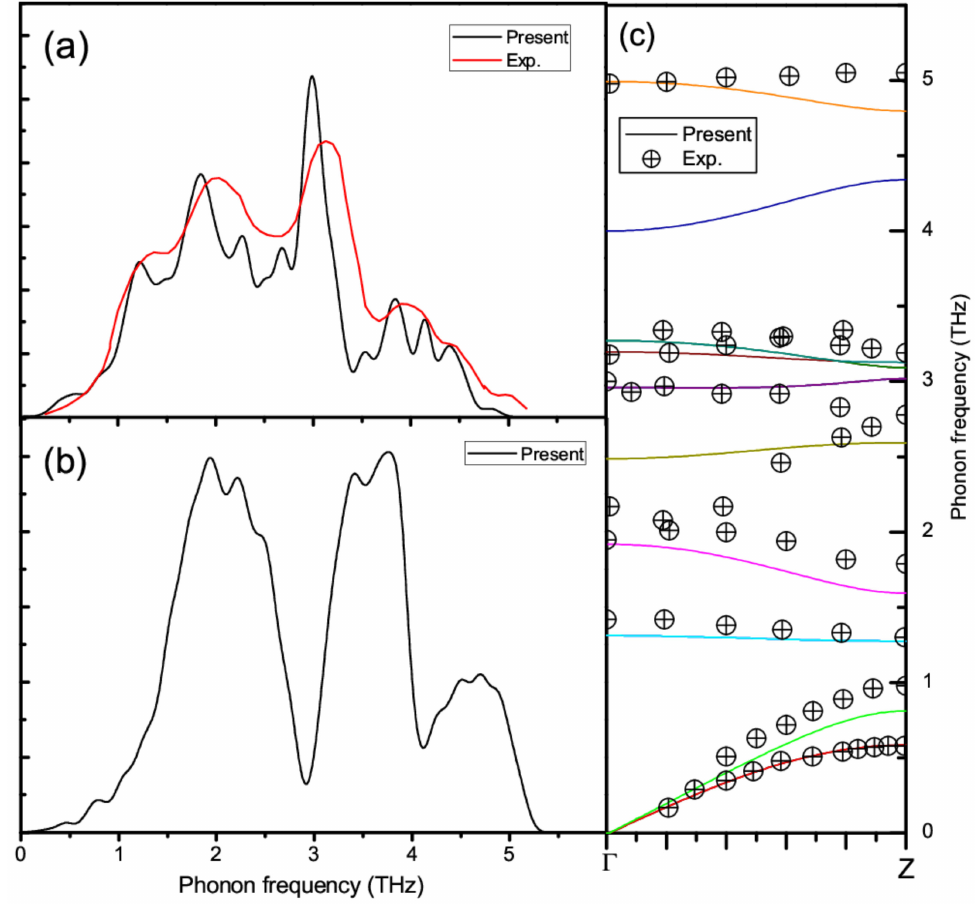
Figure 2. ( a ) Phonon DOS (black line) and the time-of-flight spectrometer data [46] (red line) for Sb 2 Te 3 , ( b ) phonon DOS for GeTe and ( c ) phonon spectra for Sb 2 Te 3 with neutron scattering data [45] (cross-filling of